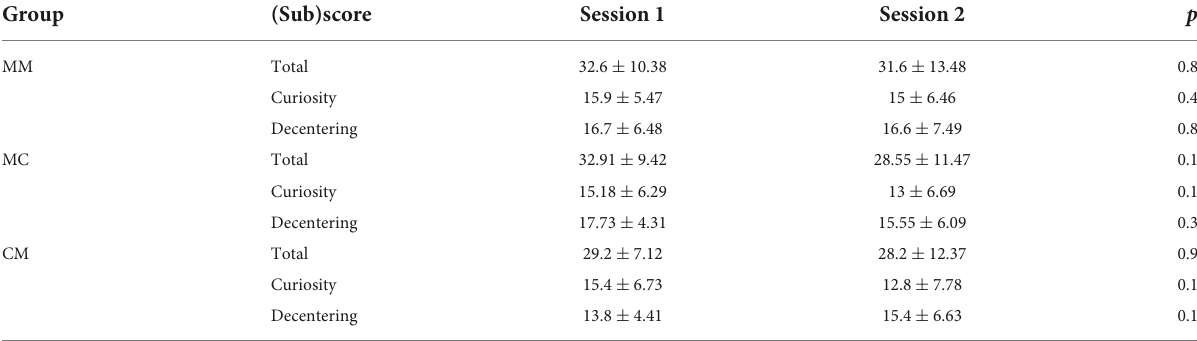
TABLE 1 Group average Toronto Mindfulness Survey and subscale scores for each session (mean ± stdev).